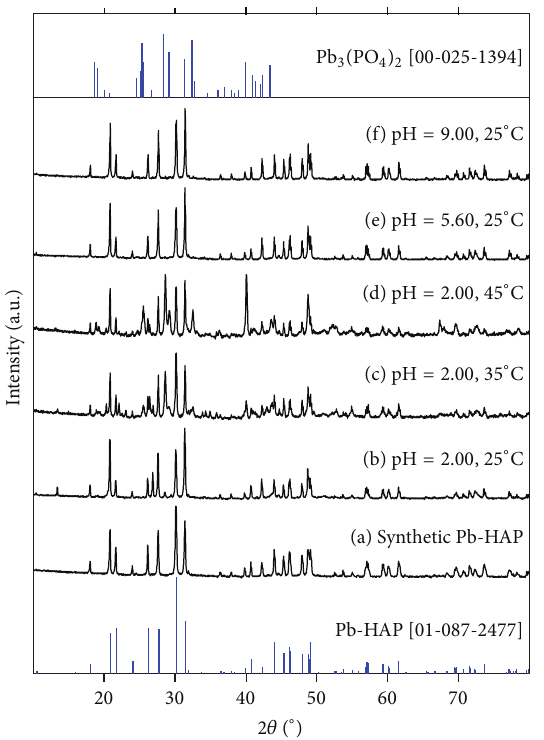
Figure 1: X-ray diffraction (XRD) patterns of the synthetic lead hydroxypyromorphite [Pb 5 (PO 4 ) 3 OH] before (a) and after (b–f) dissolution at 25–45 ∘ C for 300